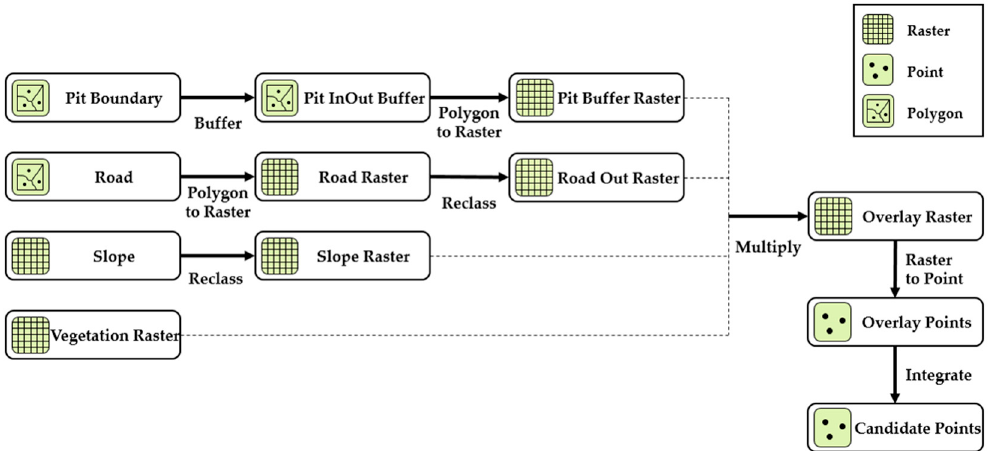
Figure 2. Flow diagram showing procedures for selecting multiple candidate locations for transmitters in geographic information systems (GIS).